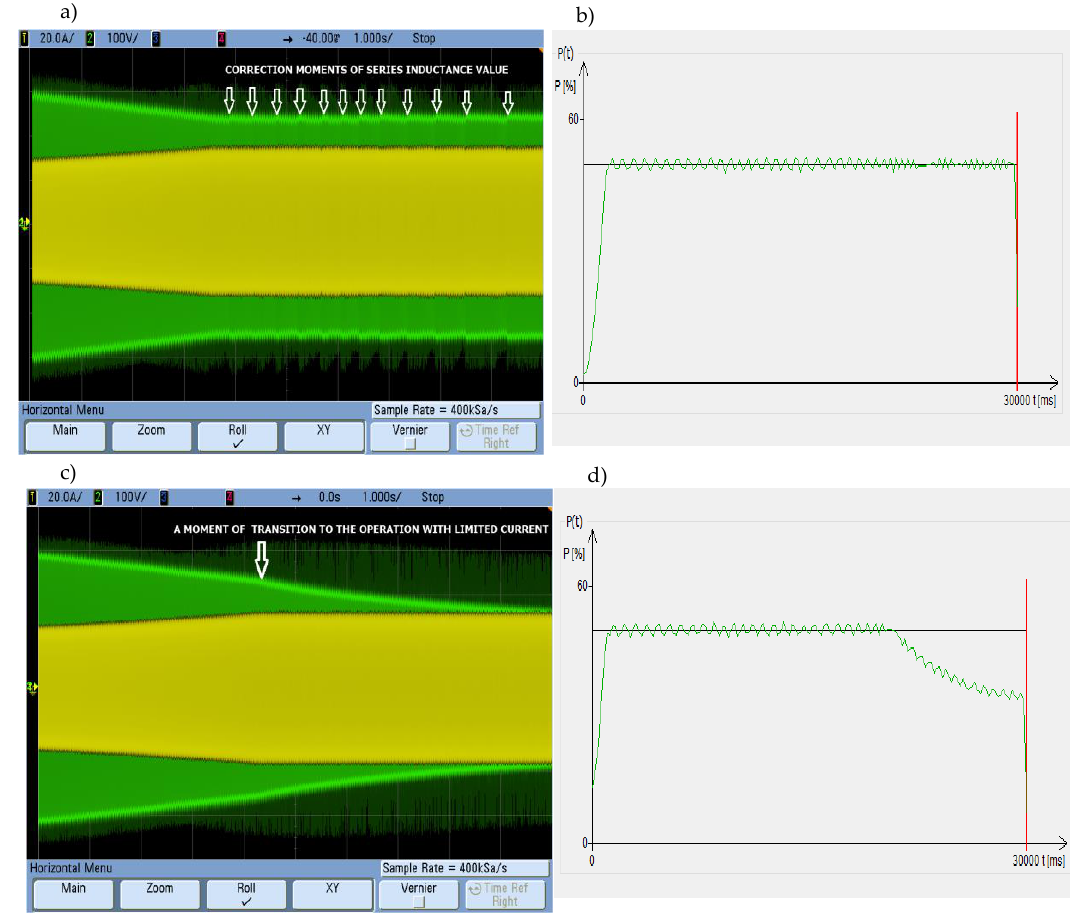
Figure 16. Current, output voltage and power waveforms for one module of the generator inverter during the heating process: ( a , b ) with L s the change procedure enabled and ( c , d ) without changing the L s settings.